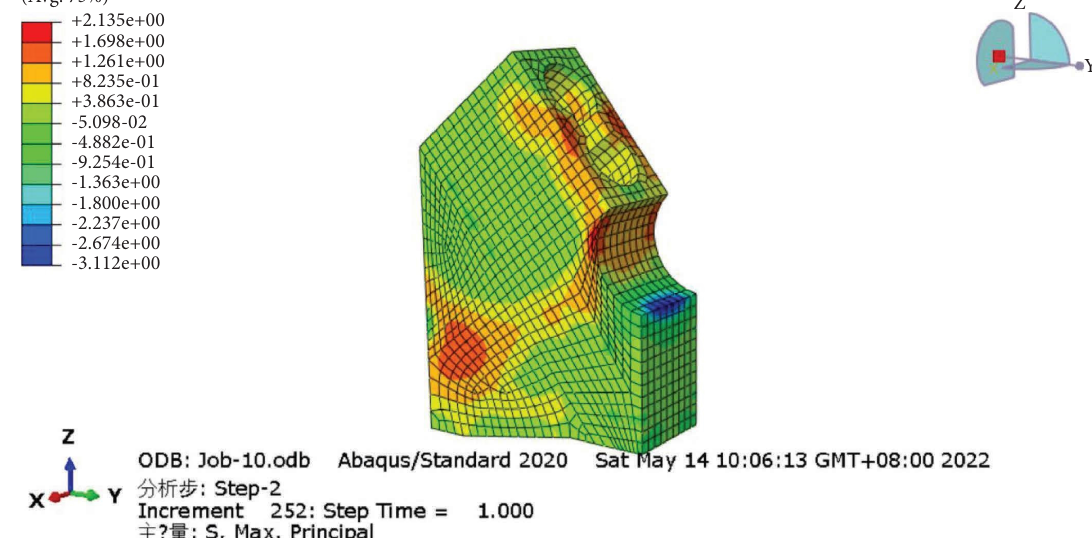
Figure 10: Cloud chart of the principal tensile stress of the arch foot without anchorage of condition